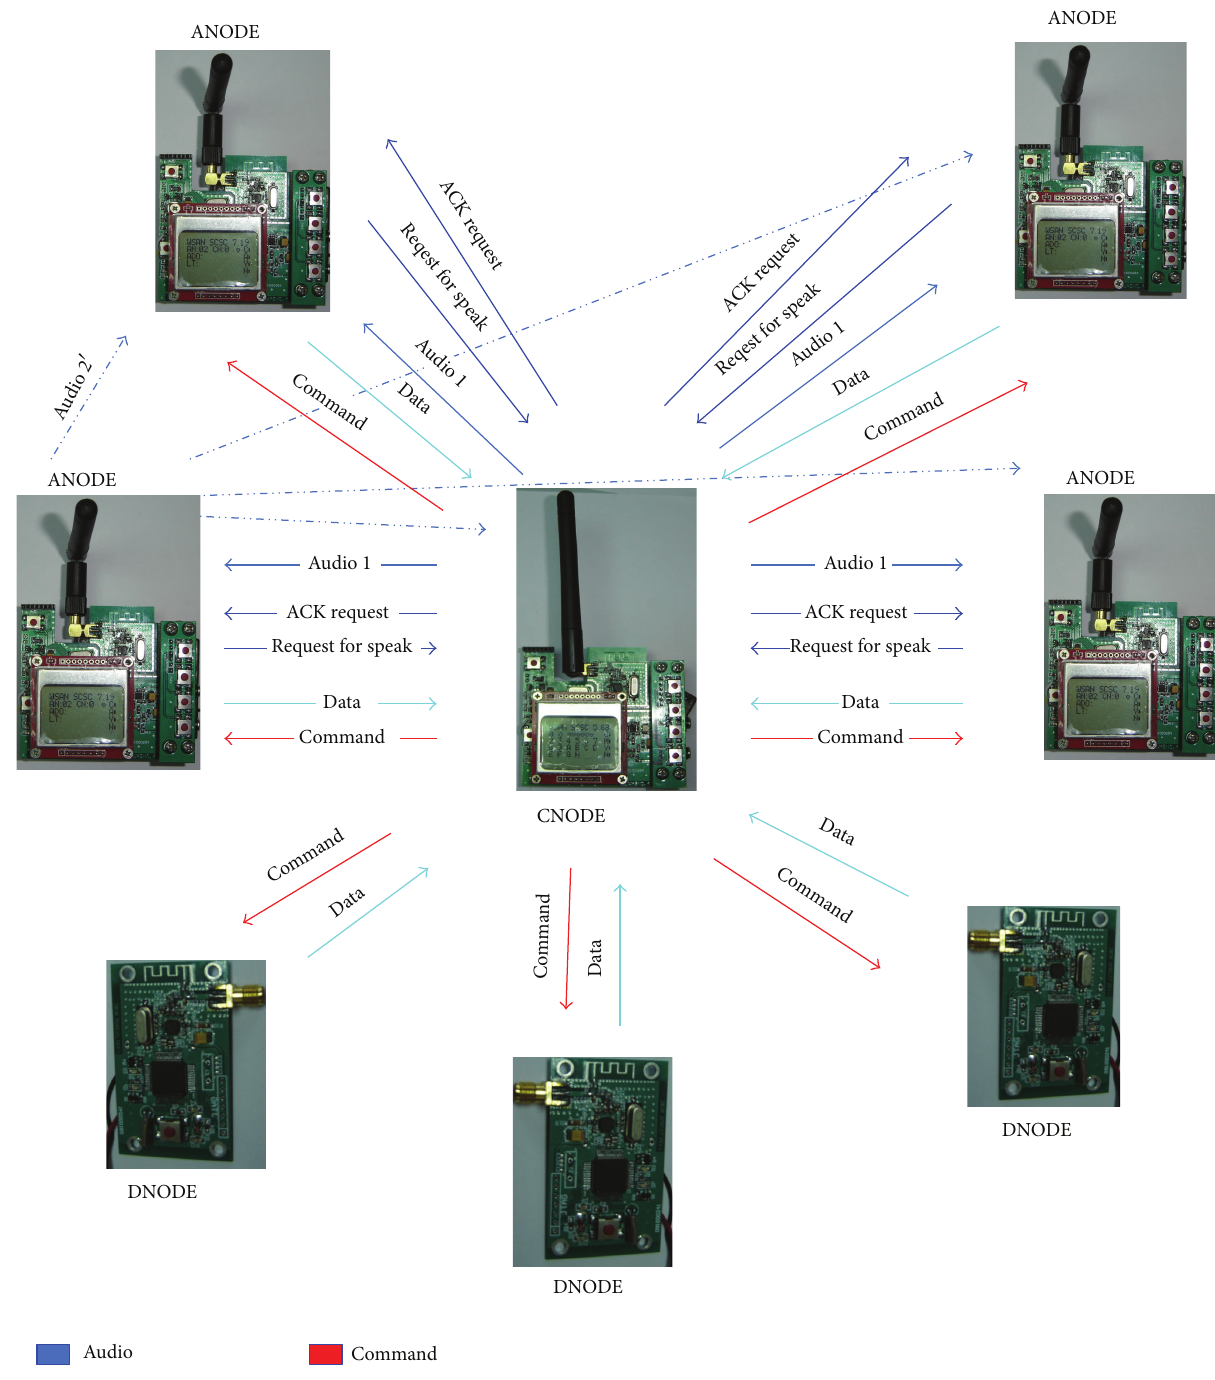
Figure 18: Schematic diagram of